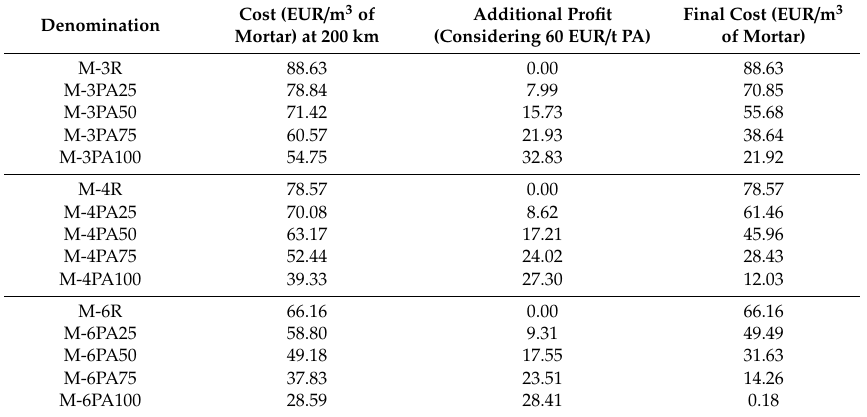
Table 15. Cost for each mortar denominations considering the saving on the waste management.